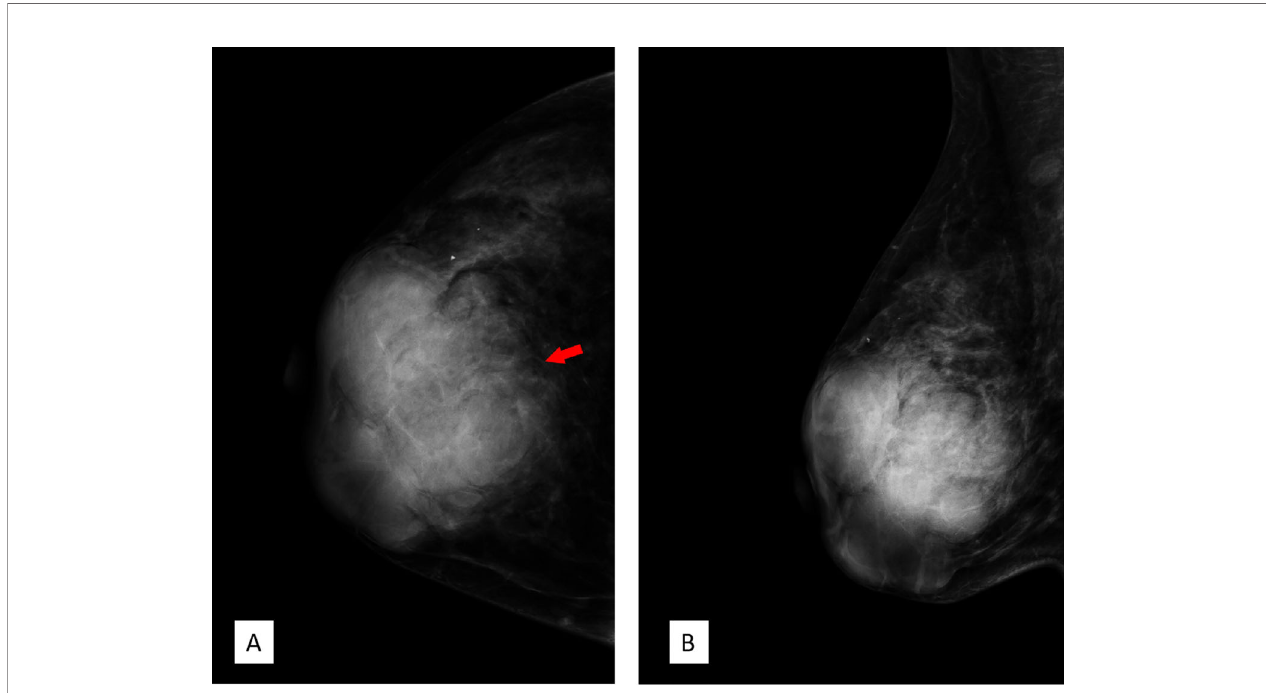
FIGURE 3 | Full- fi eld digital mammography. (A) Craniocaudal position and (B) mediolateral oblique position showed multiple high-density irregular masses, some of which were integrated with obscured septa, with multiple lobulations. Note the red arrow in panel A; the margin of the lesion was obscured by surrounding structures. Breast Imaging-Reporting and Data System (BI-RADS)